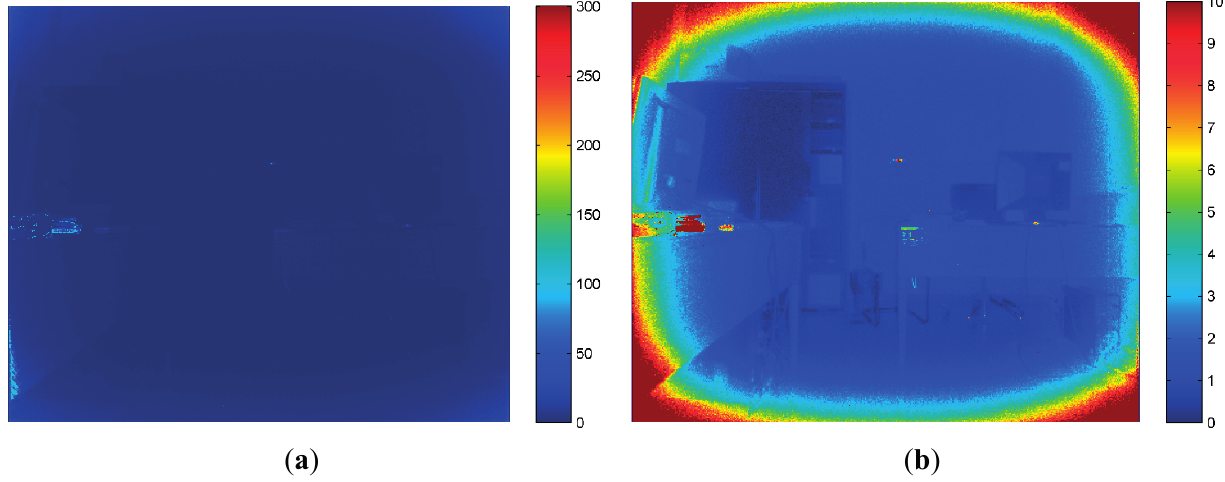
Figure 5. Standard deviation computed for each corresponding pixel for 100 subsequent IR images for Kinect 2.0. ( a ) It is the map obtained using the same scale used for Kinect 1.0; ( b ) The same image has been saturated using a different color scale, revealing an interesting radial